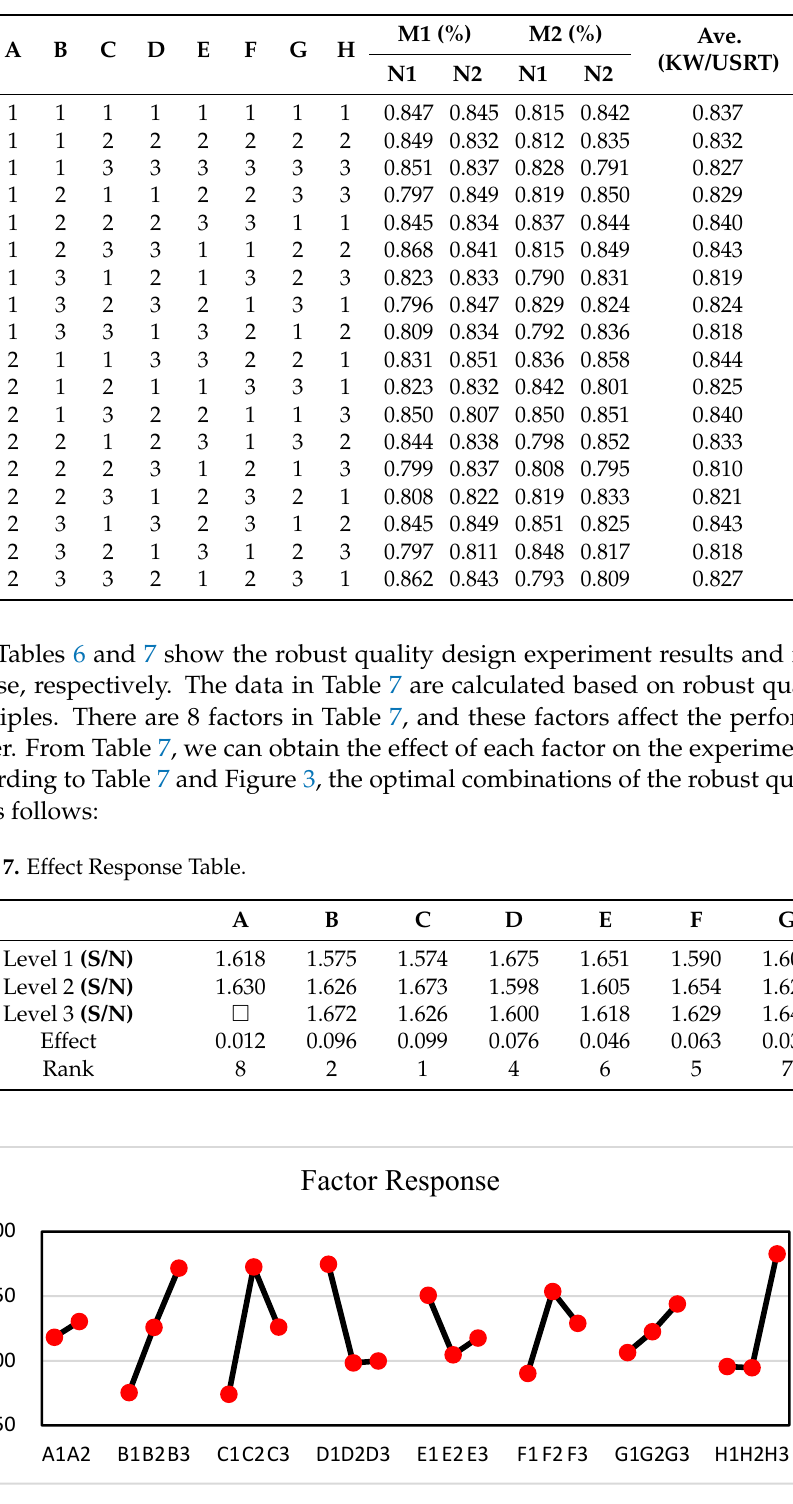
Table 6. L 18 (2 1 × 3 7 ) orthogonal array (KW/USRT).